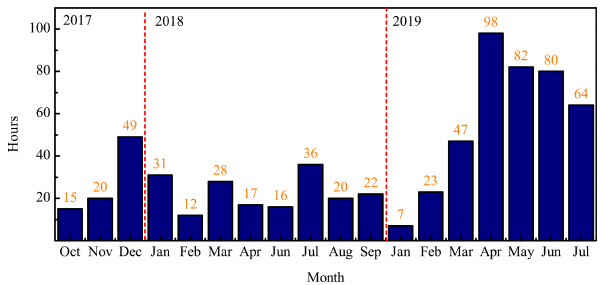
Figure 1. Effective observation hours per month from 2017 to